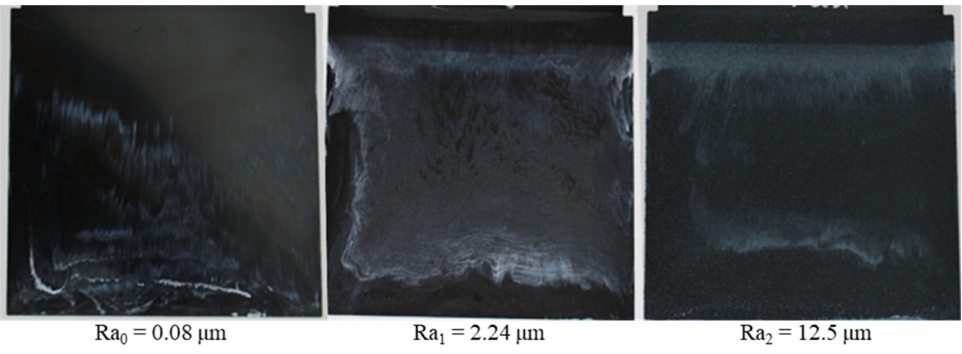
Figure 10. PF1110 (GF35+GB45); influence of surface roughness on the slip phenomenon.